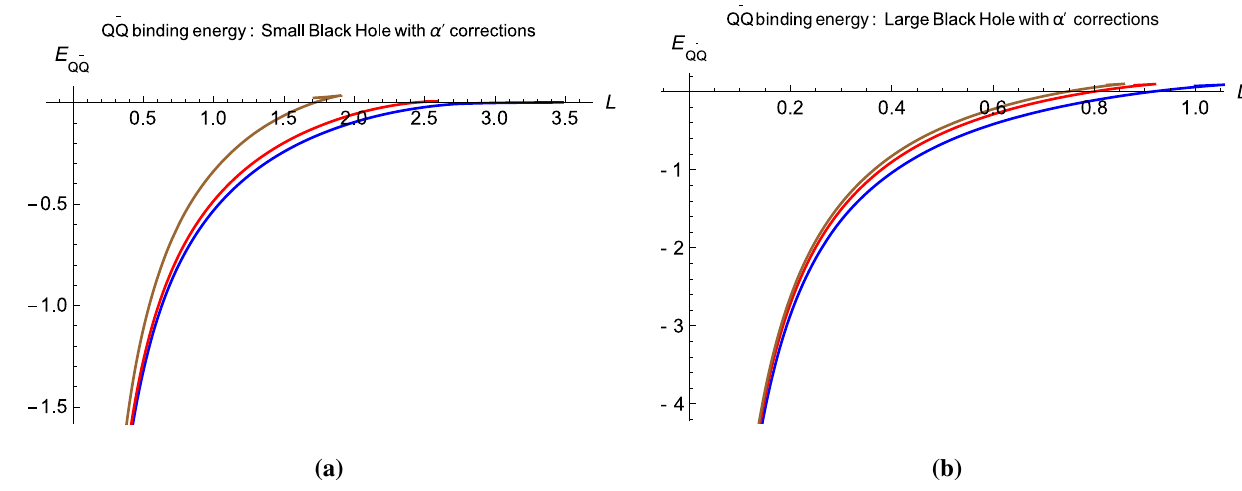
Fig. 13 Q ¯ Q binding energy vs. L for ¯ a = . 05; T = . 441; ¯ α = .001 (blue), .004 (red), .0082 (brown) a small black hole, b large black hole